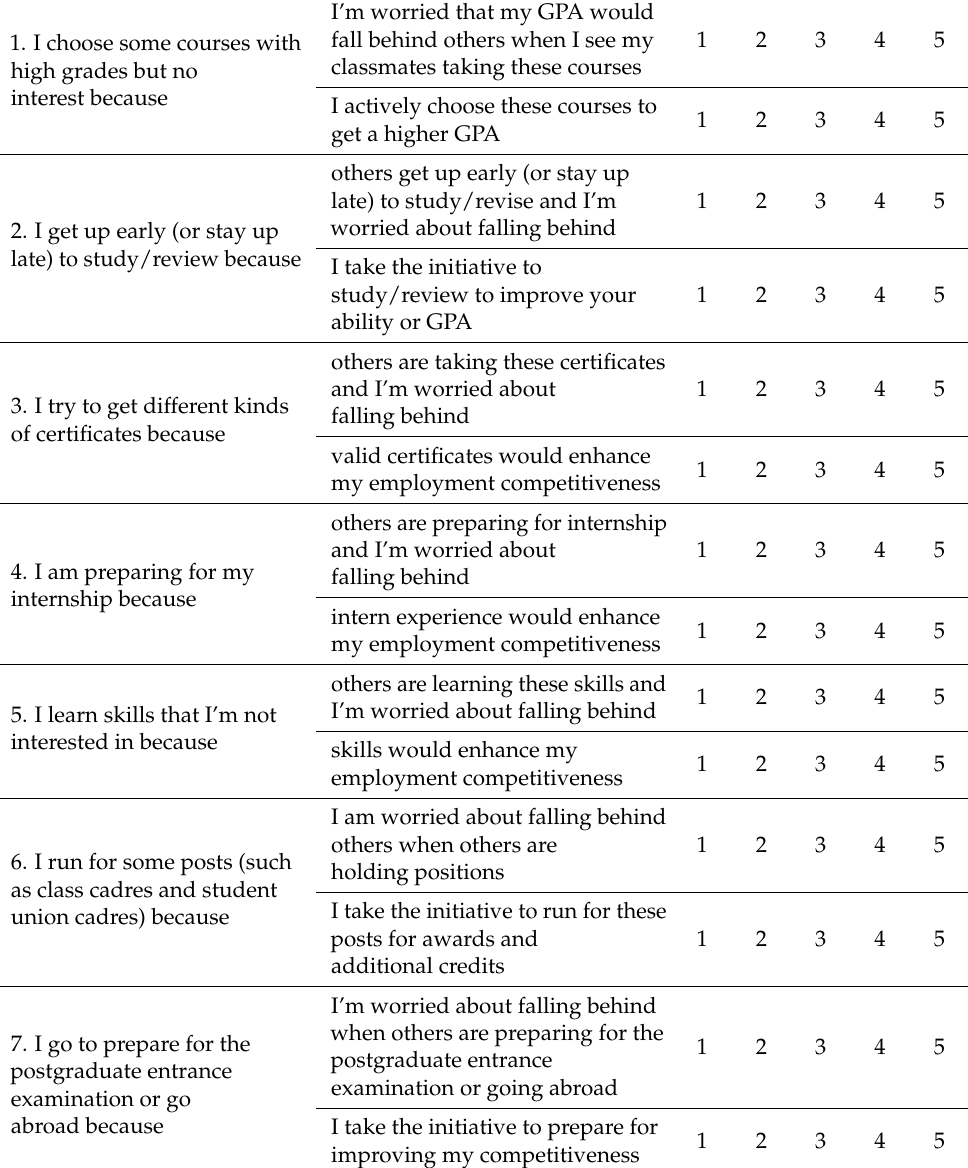
Table A1. College student involution behavior scale. Please select the option that suits your